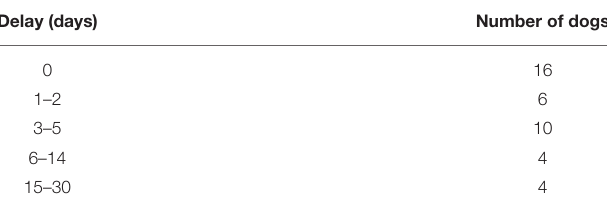
TABLE 3 | Delay between the development of signs and initiation of rehabilitation. Delay